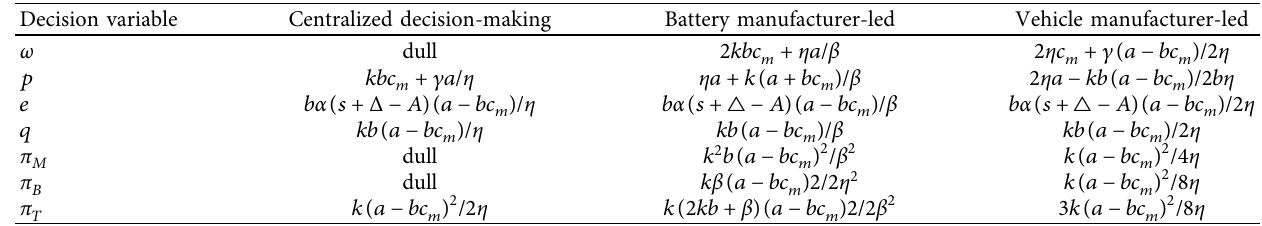
Table 2: Equilibrium solutions under each decision-making